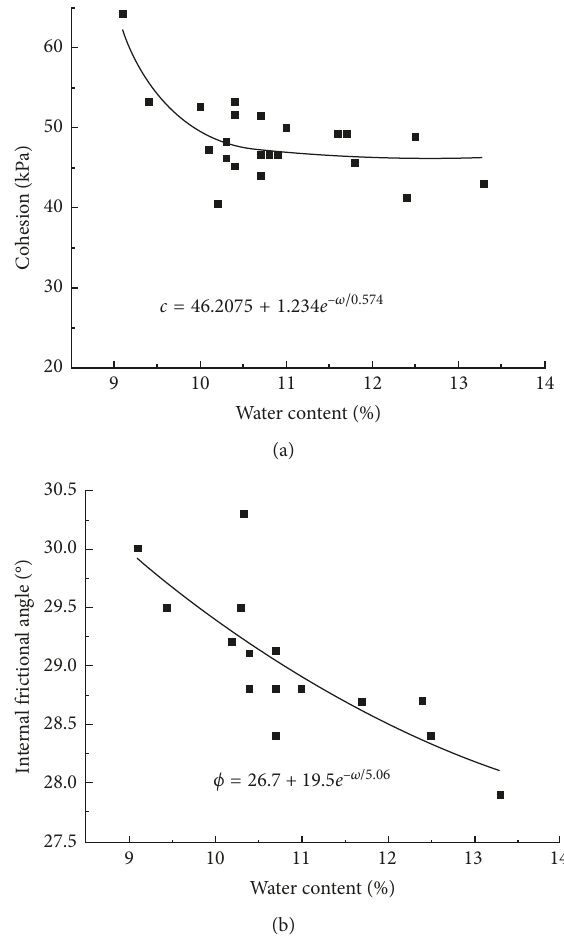
Figure 13: Shear strength of the slip zone clay with different